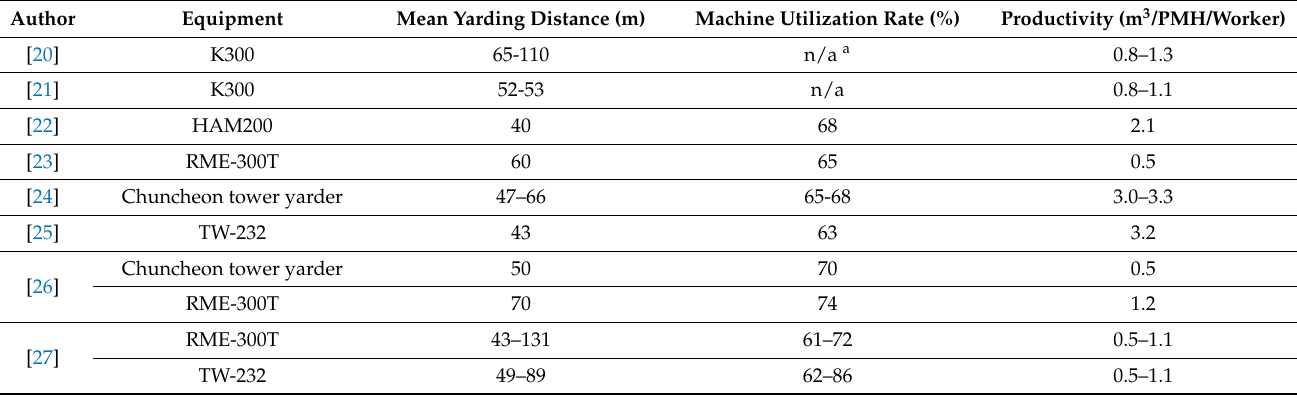
Table 4. Summary of the productivity (m 3 /productive machine hours (PMH)/worker) from previous studies, 1990–2021.